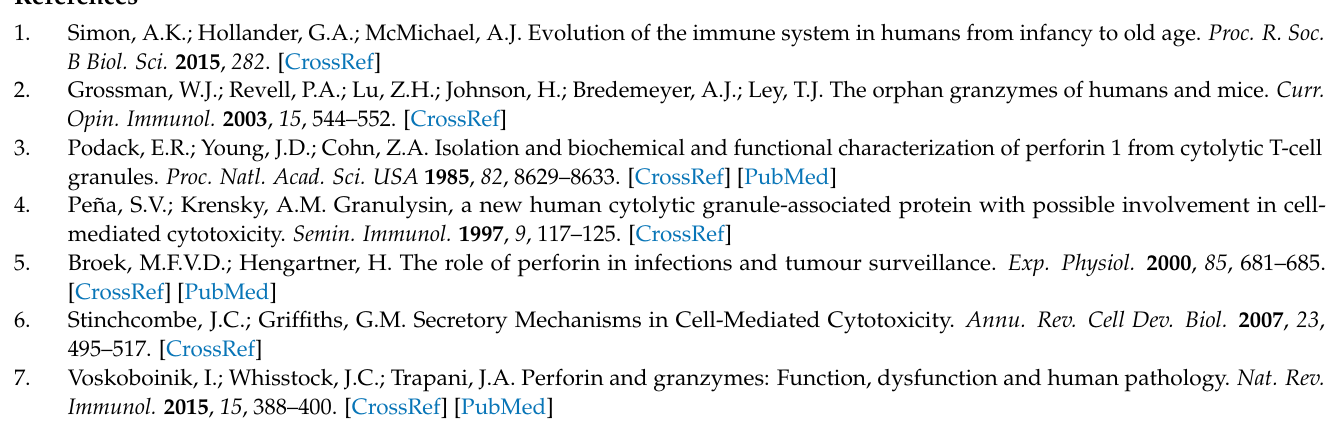
Figure S1: Variability of perforin protein in camelids, Figure S2: Variability of granulysin protein in camelids, Figure S3: Variability of trypsin-like locus granzymes in camelids, Figure S4: Variability of chymotrypsin-like locus granzymes in camelids, Figure S5: Variability of metase-like locus granzyme in camelids, Figure S6: Comparison of mapped reads for dromedary camel GZMB amplicons, Figure S7: Comparison of mapped reads for Bactrian camel GZMB